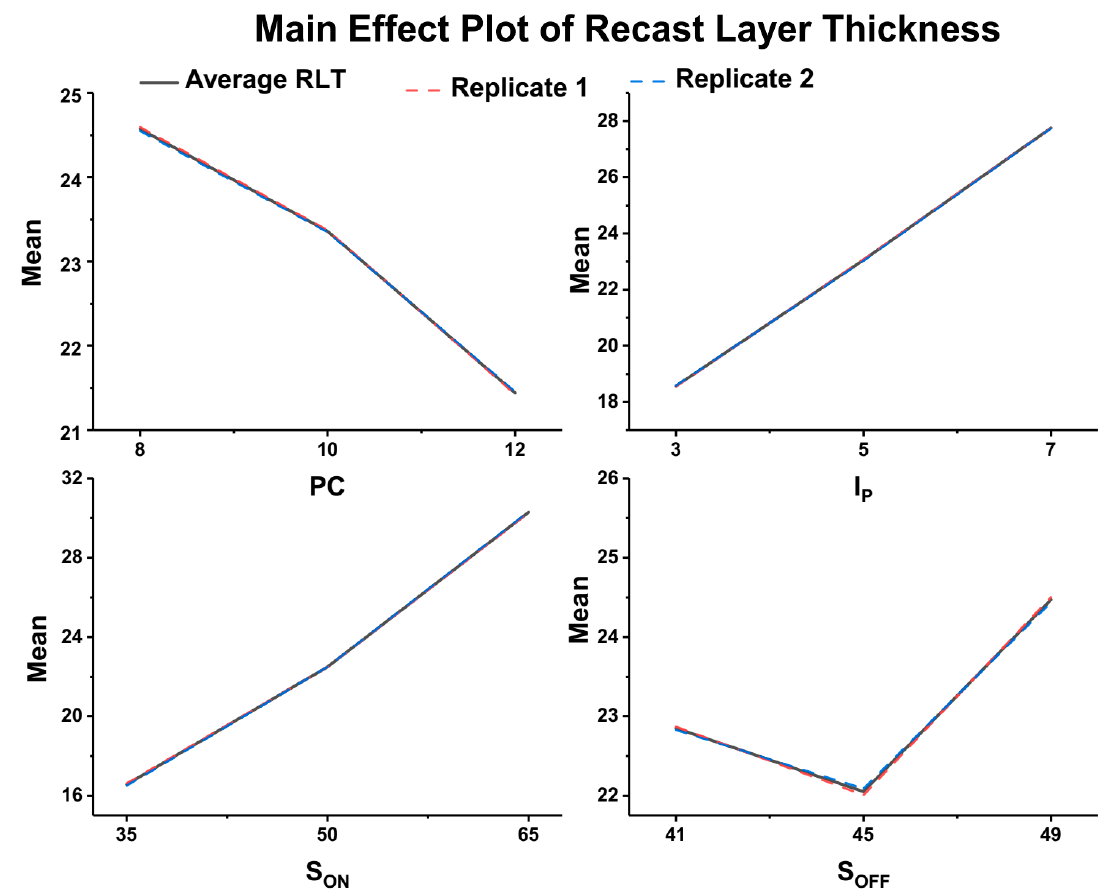
Figure 5. Main Effect Plots for Recast Layer Thickness.